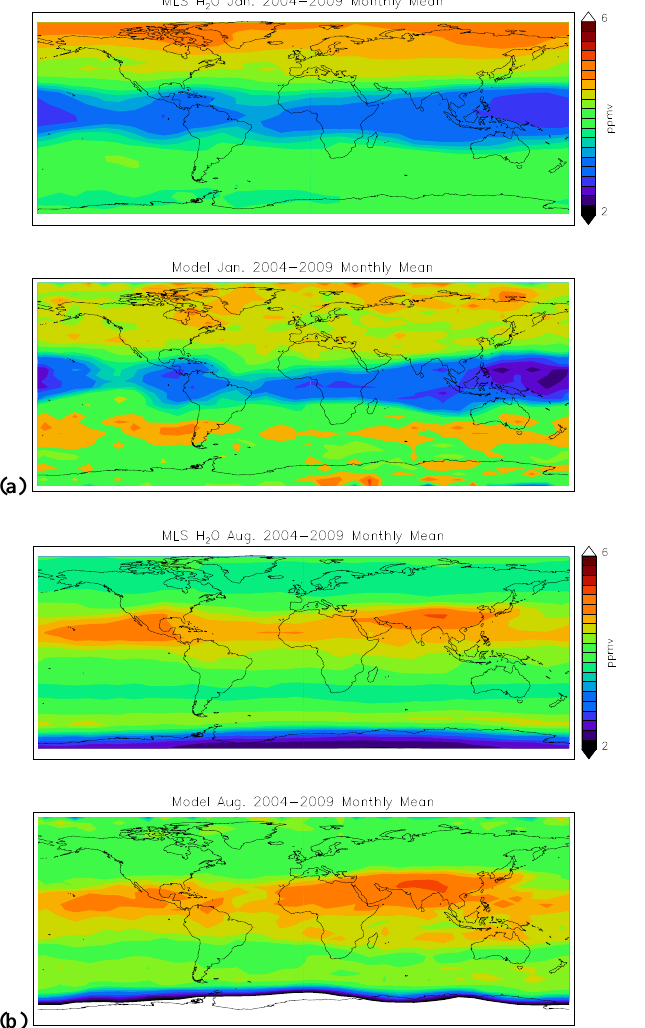
Fig. 6. Monthly mean water vapor at 82hPa ( ∼ 17.5km) for Jan- uary (a) and August 2005–2009 (b) for the model and MLS; D100 experiment.